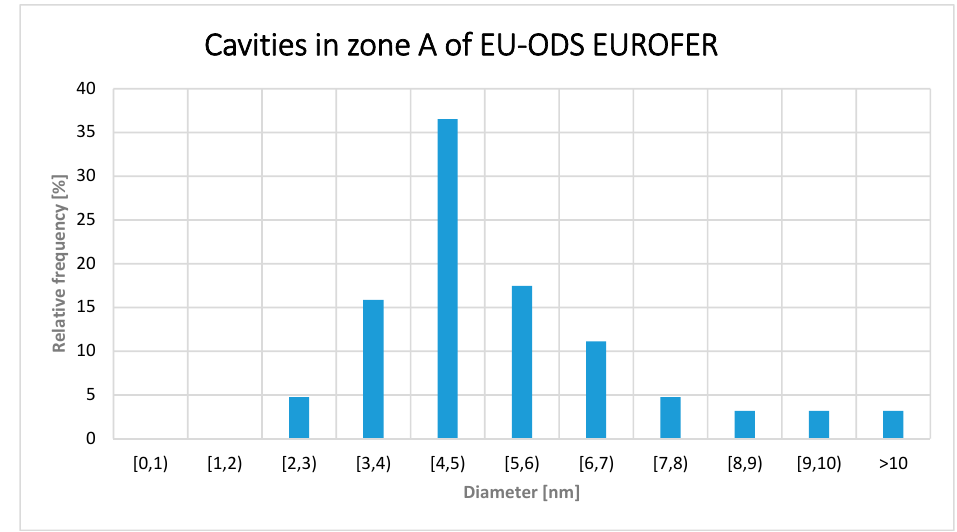
Figure 11. Cavity diameter distribution within the zone A of EU-ODS EUROFER (657–716 appm He) and annealed at 450 °C for 100 h.